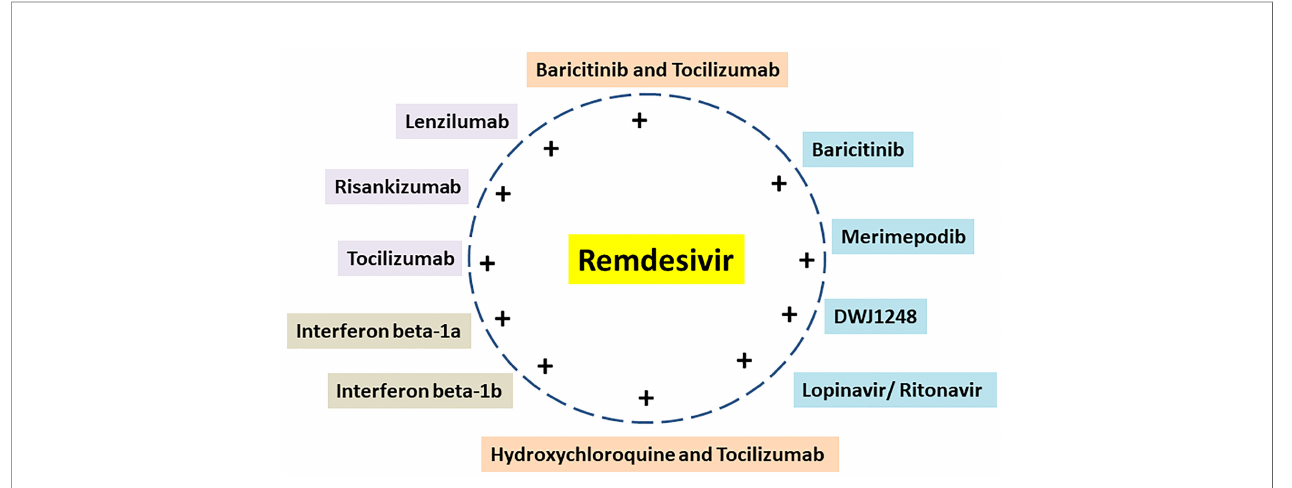
FIGURE 3 | Remdesivir and its combination with repurposed drugs under clinical trial for COVID-19